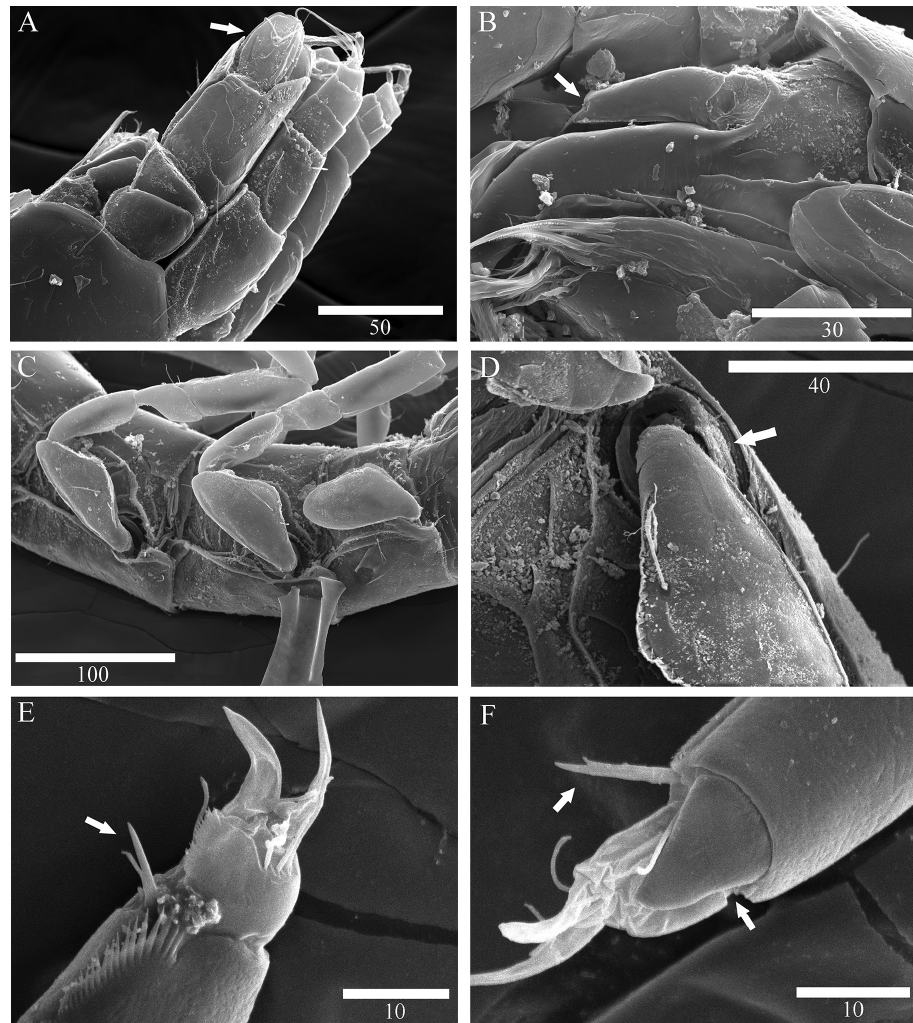
Figure 8. Scanning electron microscope images of Microcharon tanakai sp. n., A female antennal scale, lateral, B female mandibular palp, lateral C female pereopod 1-3, lateral, D female coxal plate of perepod 2, ventral E female bifurcate seta of pereopod 4, lateral, F female articular plate of pereopod 5, lateral. Scale bar unit